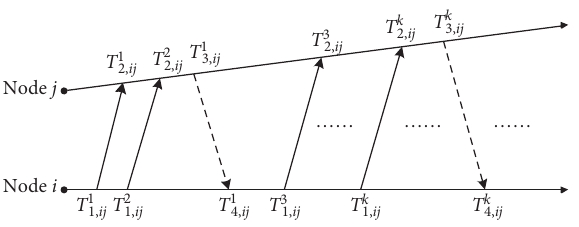
Figure 1: Two-way timing stamp exchange mechanism between node i and node j . The solid (dashed) lines denote the forward (reverse)